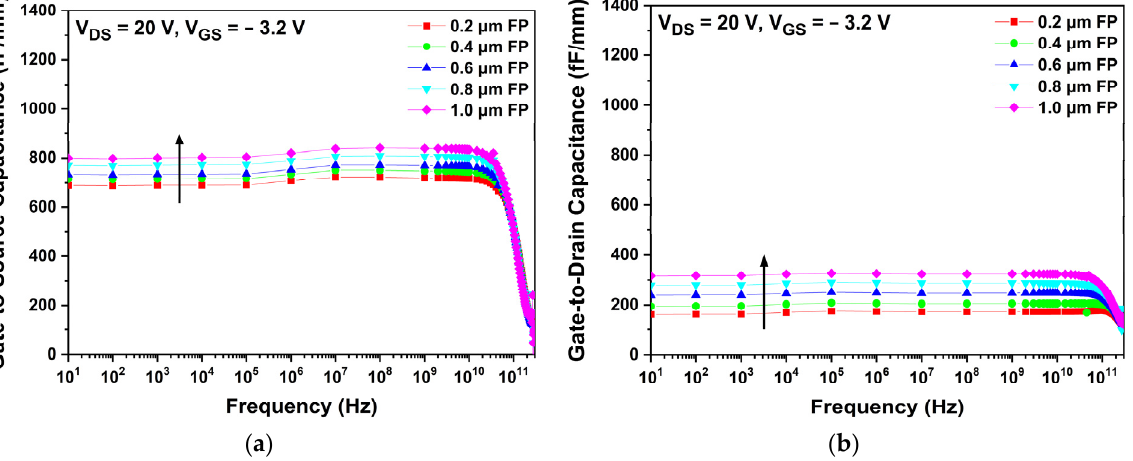
Figure 13. Capacitance characteristic variations for different lengths of drain-side extended FP: ( a ) gate-to-source capacitance; ( b ) gate-to-drain capacitance.